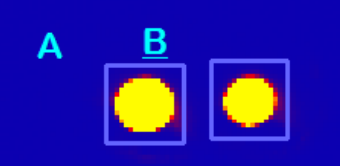
Figure 4. Example of the image captured by the camera. Two squares (A and B) delimiting the integration area around the IR beams can also be seen.